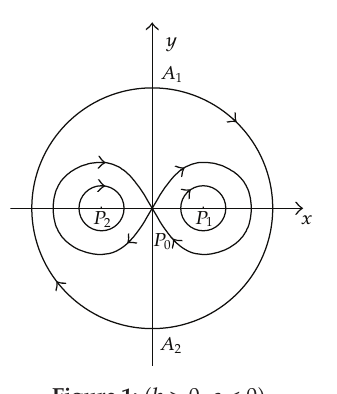
Figure 1: (cid:6) b > 0, c < 0 (cid:7)